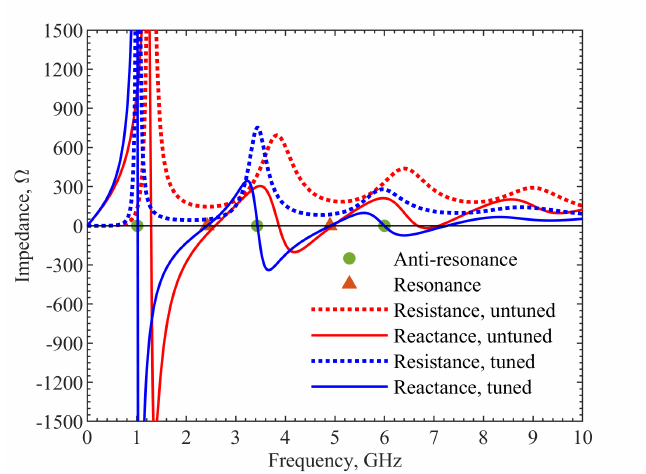
Figure 12. Comparison of impedances from the equivalent circuits of loop resonators of U = 9 tuned and untuned. The first three anti-resonance and two resonance points are labeled for the tuned loop resonator where the reactance become zero (blue, solid curve). The real part of the impedance (blue, dotted curve) distinguishes resonance from anti-resonance.